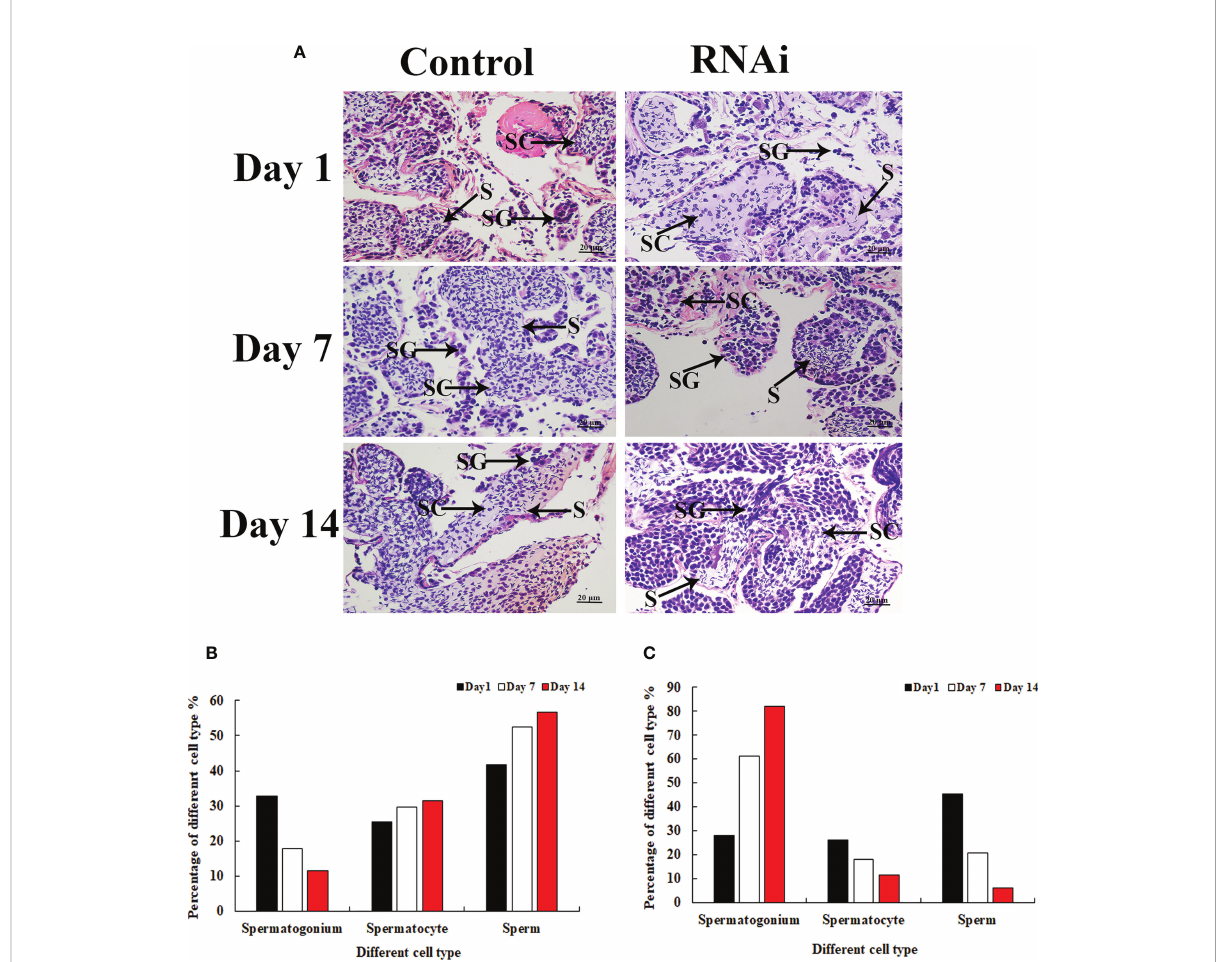
FIGURE 7 The histological observations of testis between RNAi and control group. SG, Spermatogonia; SC, spermatocyte; S, sperm. Scale bars = 20 m m. (A) The histological observations of testis taken from the dsGFP and dsPlk1 injected prawns. (B) The percentage of different cell types in the testis of dsGFP injected prawns. (C) The percentage of different cell types in the testis of dsPlk1 injected prawns.